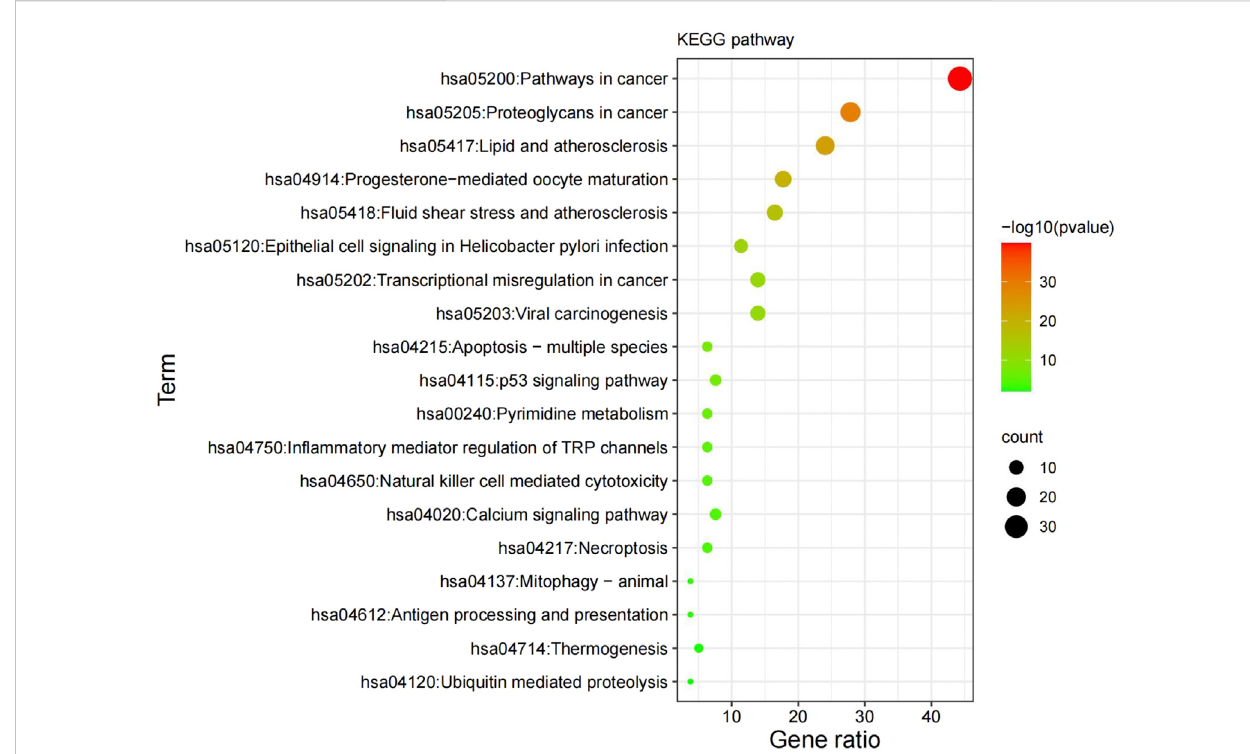
FIGURE 4 Results of the KEGG enrichment analysis. KEGG, Kyoto Encyclopedia of Genes and